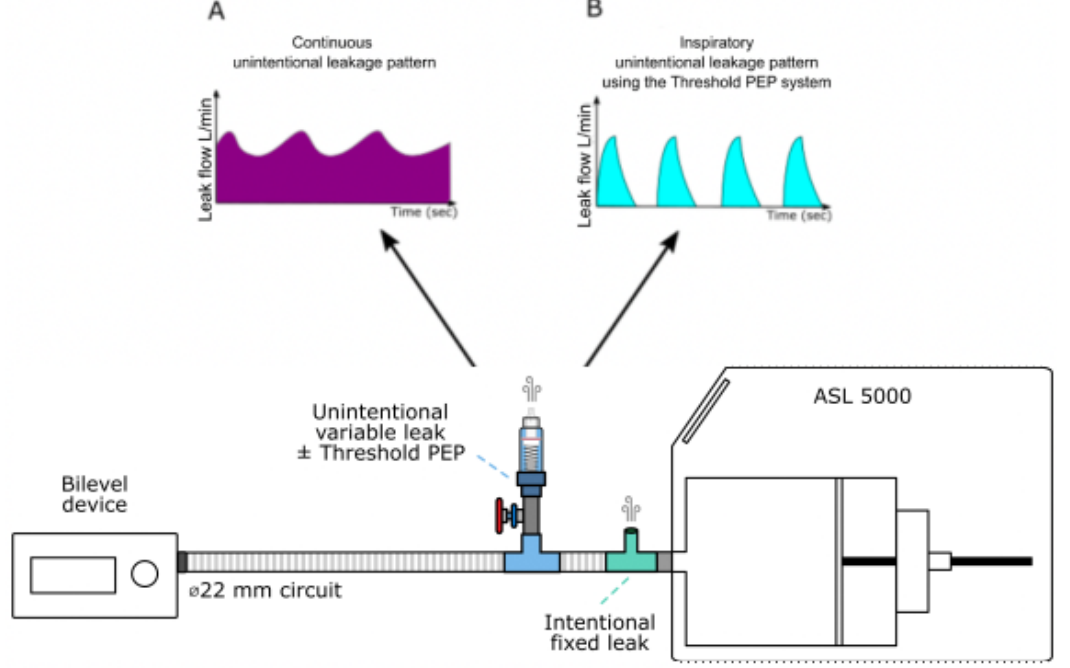
Figure 1. Experimental setup used to generate intentional and unintentional leakages. ASL 5000: artificial lung. ( A ) represents a schematization of the continuous leakage pattern observed when the Threshold PEP system is not activated. ( B ) represents a schematization of the inspiratory uninten- tional leakage (intermittent) pattern observed when the Threshold PEP is activated: in that condi- tion, leakage occurs only when the pressure is higher or equal to 6 cmH20, therefore only during the inspiratory phase.